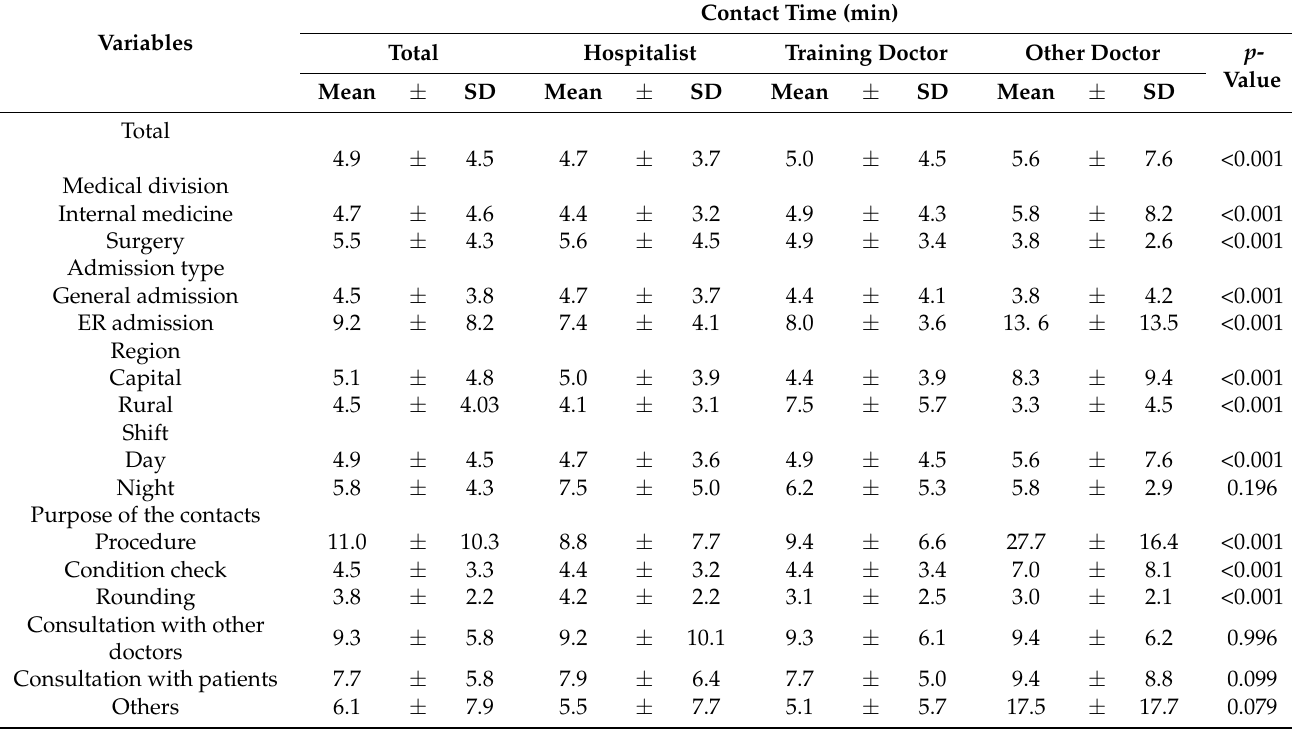
Table 2. Average of patient–doctor contact duration per